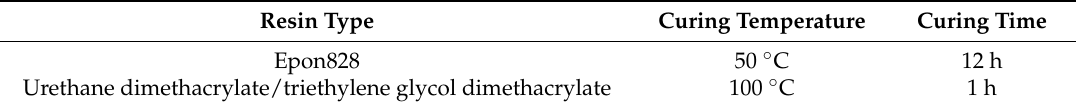
Figure 4. ( a ) Mold for printed braiding structure and resin impregnation . Left: printed braiding structure was put into the silicone rubber mold and resin was then infused into the mold; right: resin was infused into the silicone mold directly. Specimens for compression test: ( b ) specimen with printed braiding structures and resin matrix; ( c ) specimen of pure resin matrix. Table 3. Resin curing parameters.